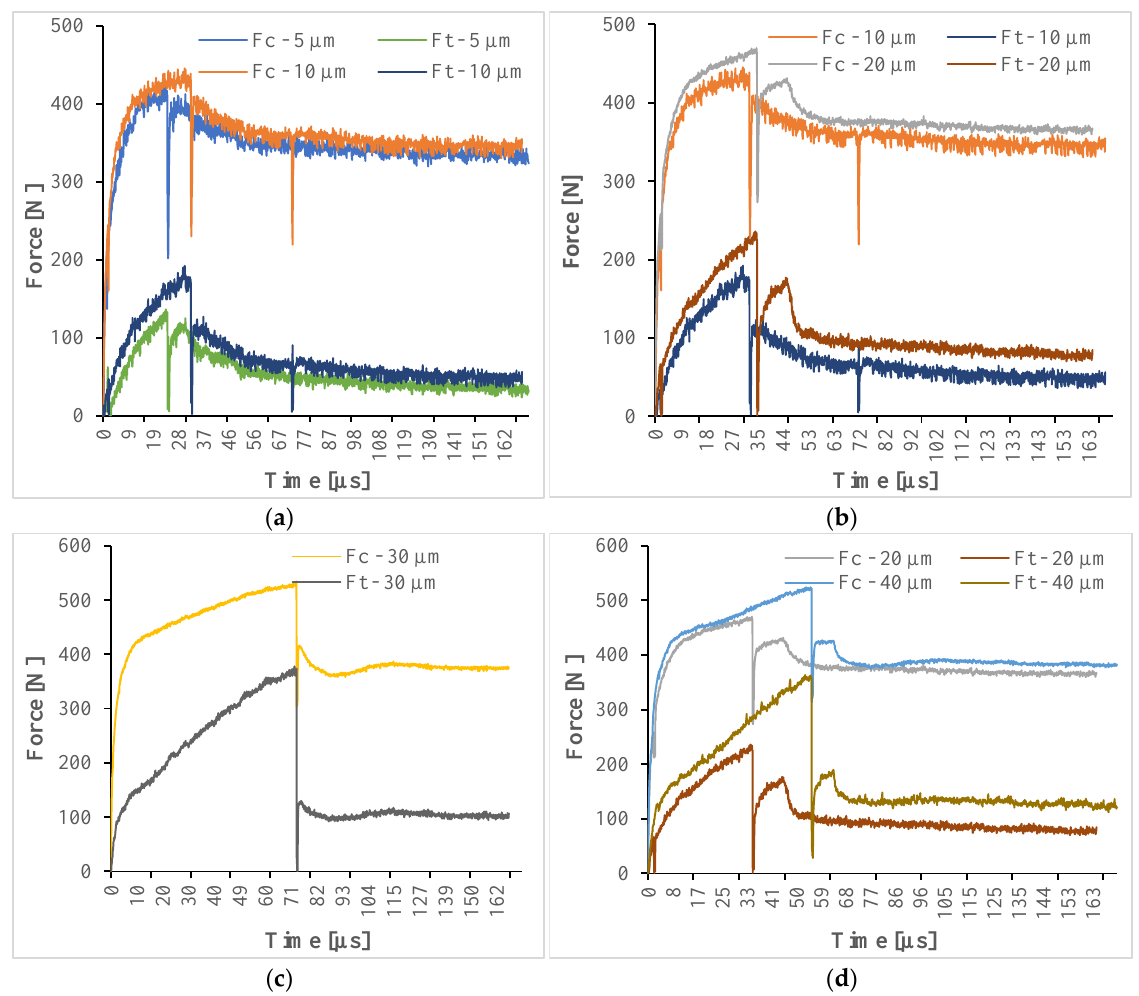
Figure 4. Force distribution during cutting process for different edge radius (α = 7° and γ = 17.5°): ( a ) 5–10 µm, ( b ) 10–20 µm, ( c ) 30 µm, and ( d ) 30–40 µm.